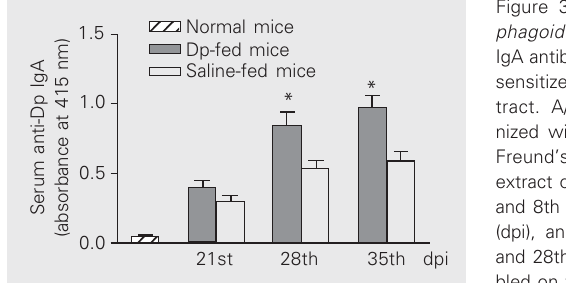
dpi and individual sera were assayed for anti-Dp IgA antibodies by ELISA. Data are reported as means ± SEM for 4-7 mice in each group of four independent experiments. *P < 0.05 compared to saline-fed mice (unpaired Student t -test). are reported as means ± SEM for 3-6 mice in each group of four independent experiments. *P < 0.05 when compared to normal mice (unpaired Student t -test).